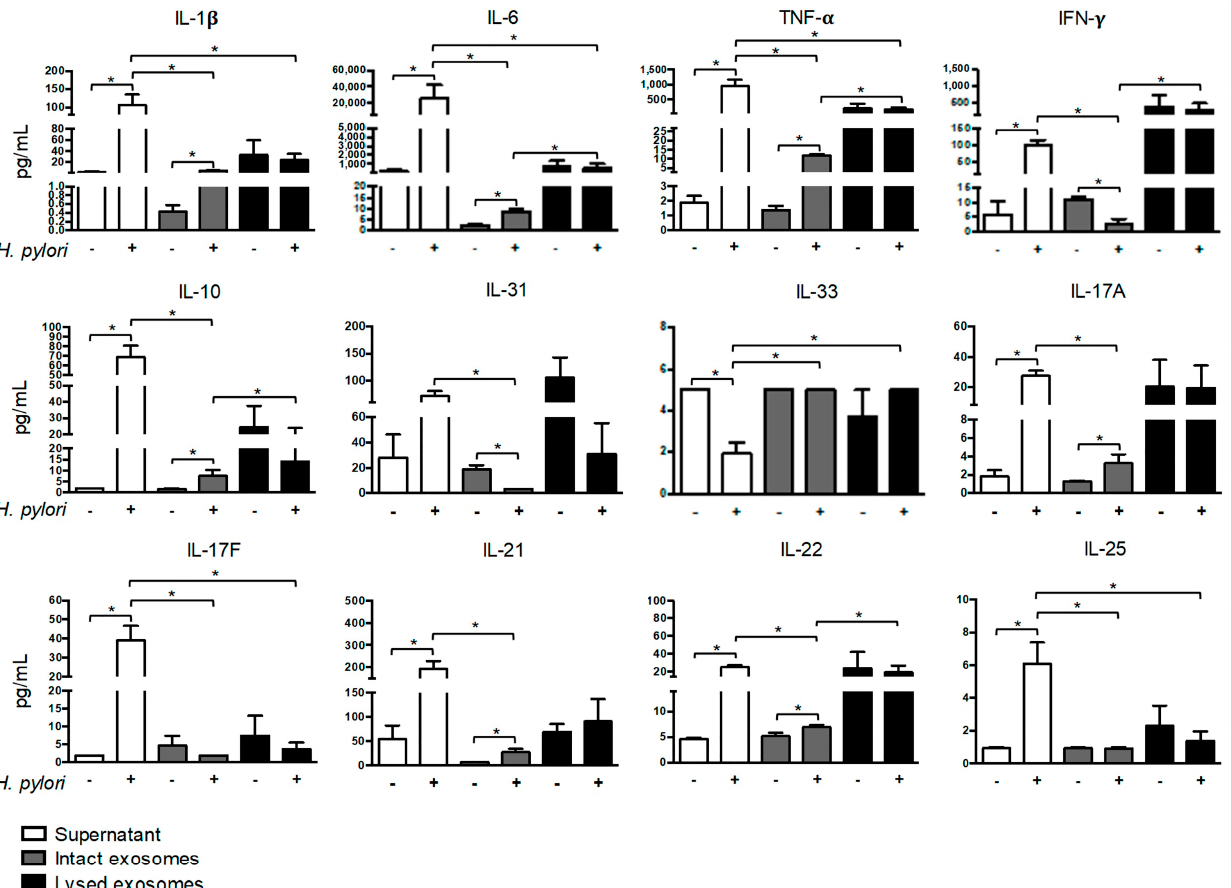
Figure 3. H. pylori induces the secretion of soluble and exosomal cytokines in PBMCs. The concentration of IL-1 β , IL-6, TNF- α , IFN- γ , IL-10, IL-31, IL-33, IL-17A, IL-17F, IL-21, IL-22, and IL-25 was determined in supernatant, intact exosomes, and lysed exosomes that were secreted by the Control-PBMCs and H. pylori -PBMCs by a bead-based multiplex immunoassay. The graphs show the mean ± SEM. Comparison between the groups was performed using the Mann–Whitney U test, and differences were considered statistically significant when * p < 0.05 . All the experiments were performed in triplicate.